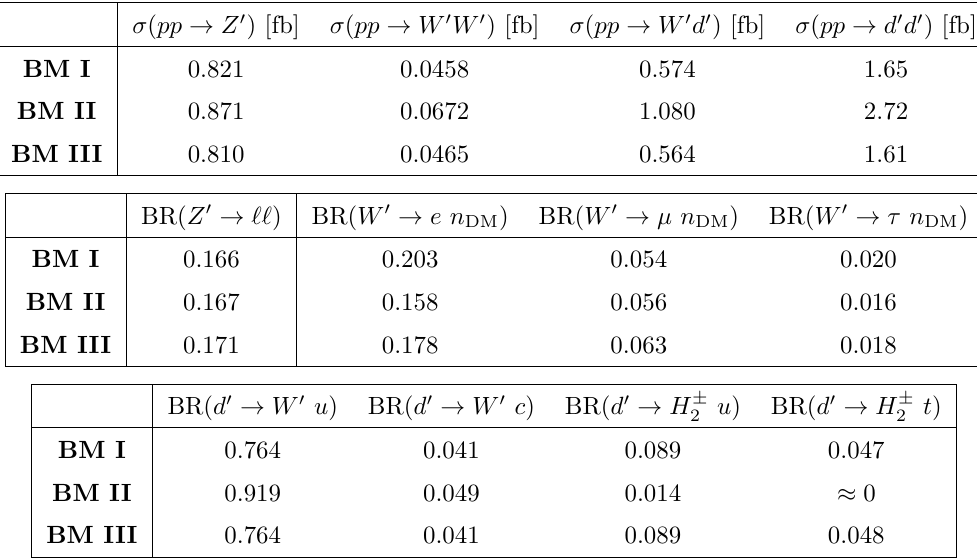
Table 6 . Predictions, for the BM I , BM II and BM III scenarios, of various quantities relevant for the associated LHC phenomenology at a centre-of-mass energy of 13 TeV. In our notation, ‘ equivalently denotes an electron or a